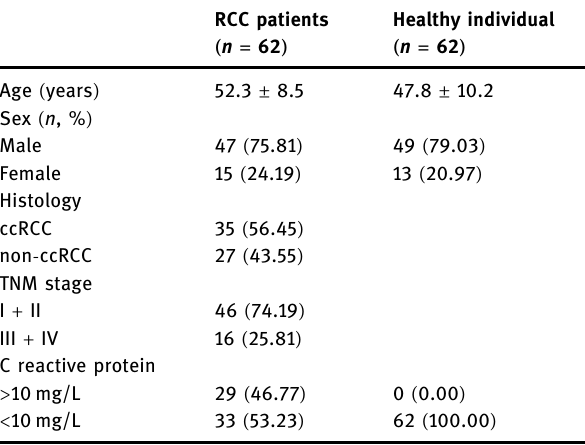
Table 1: Clinicopathological information of the enrolled